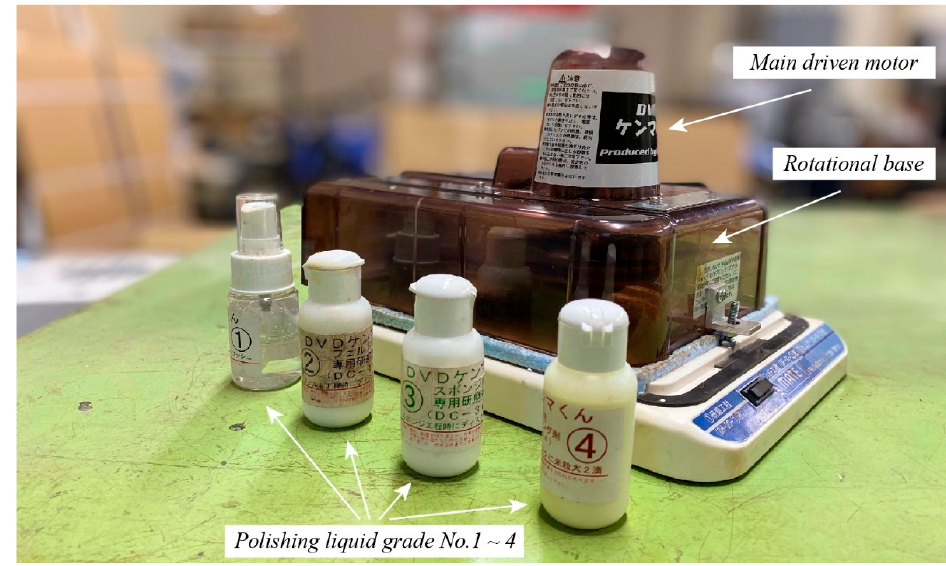
Figure 5. A self-configured plastic gear polisher. Originally, this is a DVD polisher by Kenmac. Figure 6 specifies the roughness chart of the accomplished polishing process. In this